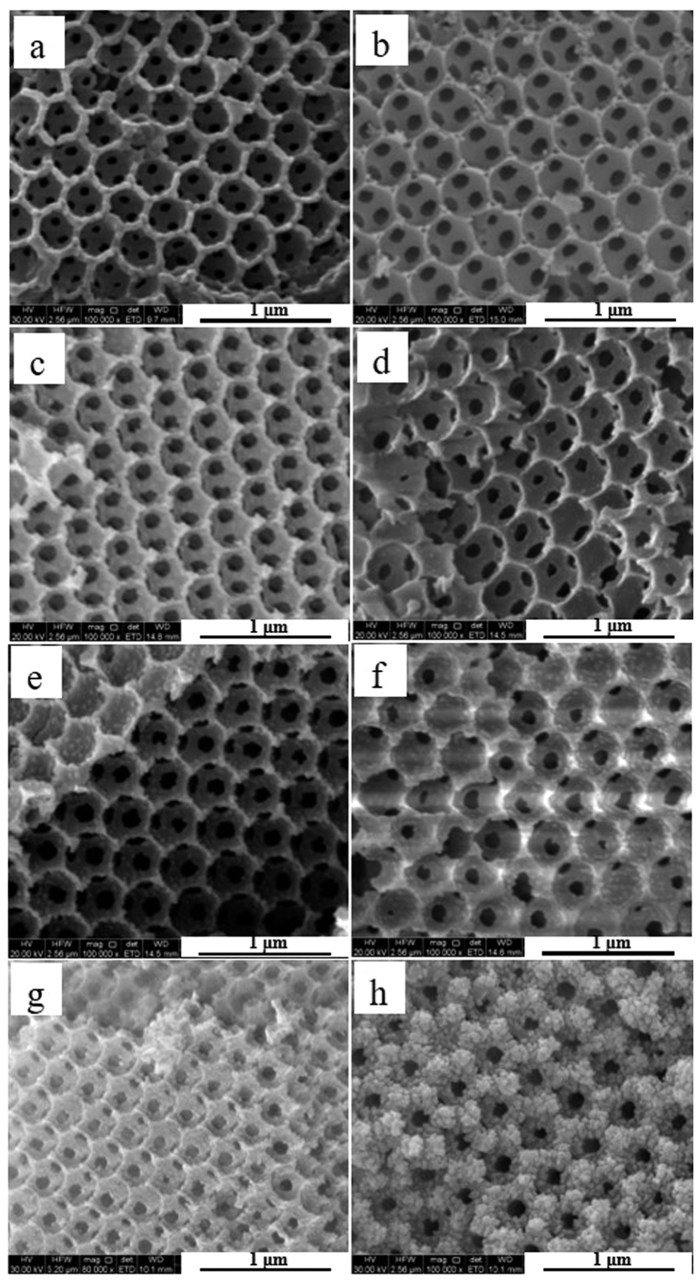
SEM images of 3DOM K-OMS-2/SiO2.SiO2 (a); K-OMS-2/SiO2-10 (b); K-OMS-2/SiO2-20 (c); K-OMS-2/SiO2-30 (d); K-OMS-2/SiO2-40 (e); K-OMS-2/SiO2-50 (f); K-OMS-2/SiO2-60 (g); K-OMS-2/SiO2-70 (h).